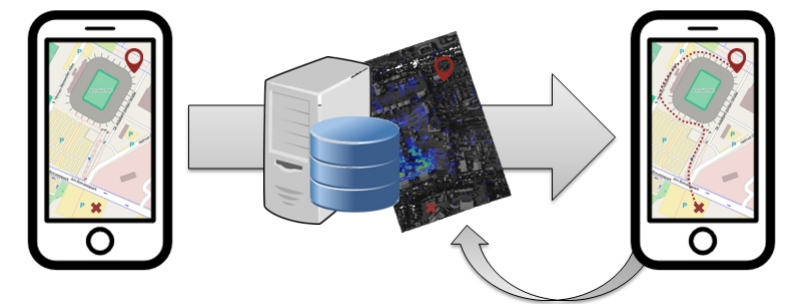
Figure 5. Conceptual design of a smartphone app for least-cost routing during or after a major event (in this case a football